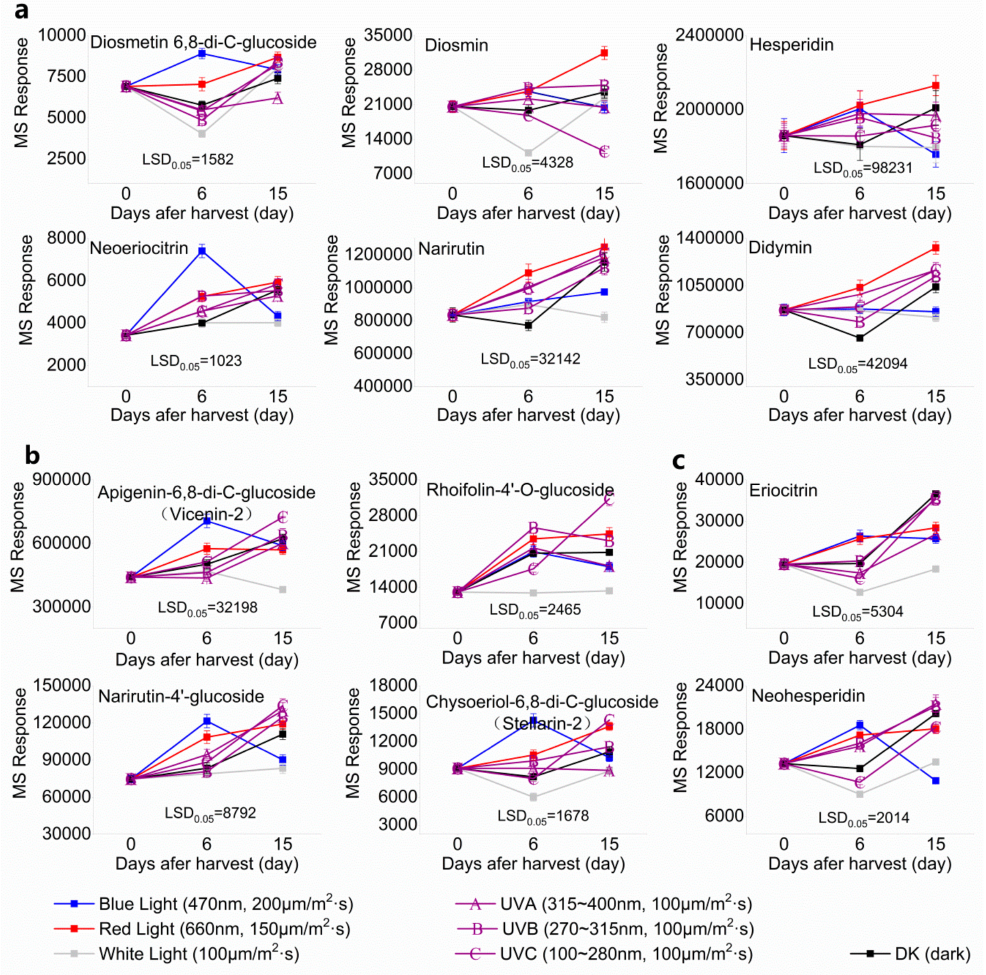
Figure 3. MS response of flavone and flavanone in the segments of Newhall navel orange during light irradiation and during the removal period. Flavone and flavanone ( a ) were mostly induced by red light, ( b ) UVC, and were also ( c ) induced by UV and